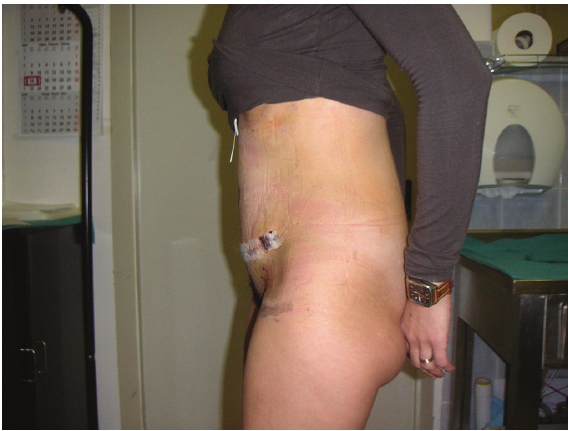
Figure 5: Post operative lateral